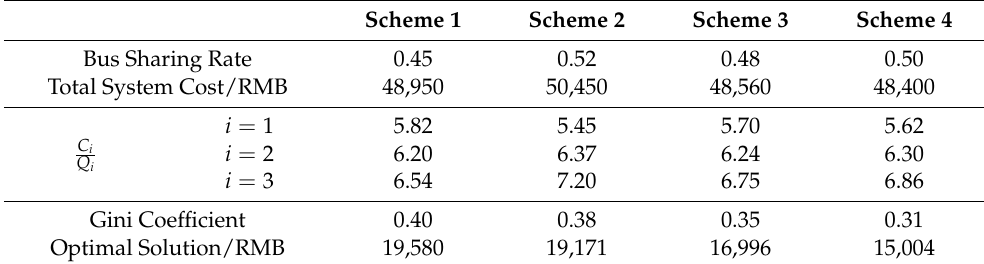
Table 6. Comparative analysis of different allocation schemes.